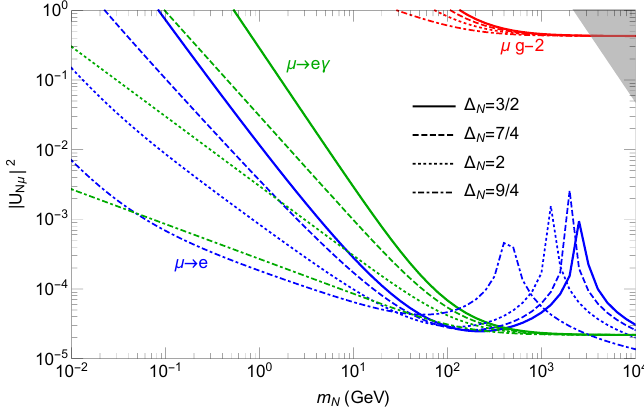
Figure 11 . Constraints on neutrino mixing as a function of the singlet neutrino mass scale from muon g-2 (red lines), µ → eγ (green lines), and µ - e conversion (blue lines) experimental measure- ments, for benchmark choices of ∆ of 3/2 (solid lines), 7/4 (dashed lines), 2 (dotted lines), 9/4 N (dot-dashed lines). In the gray region the boundary condition in eq. (2.18) is violated.